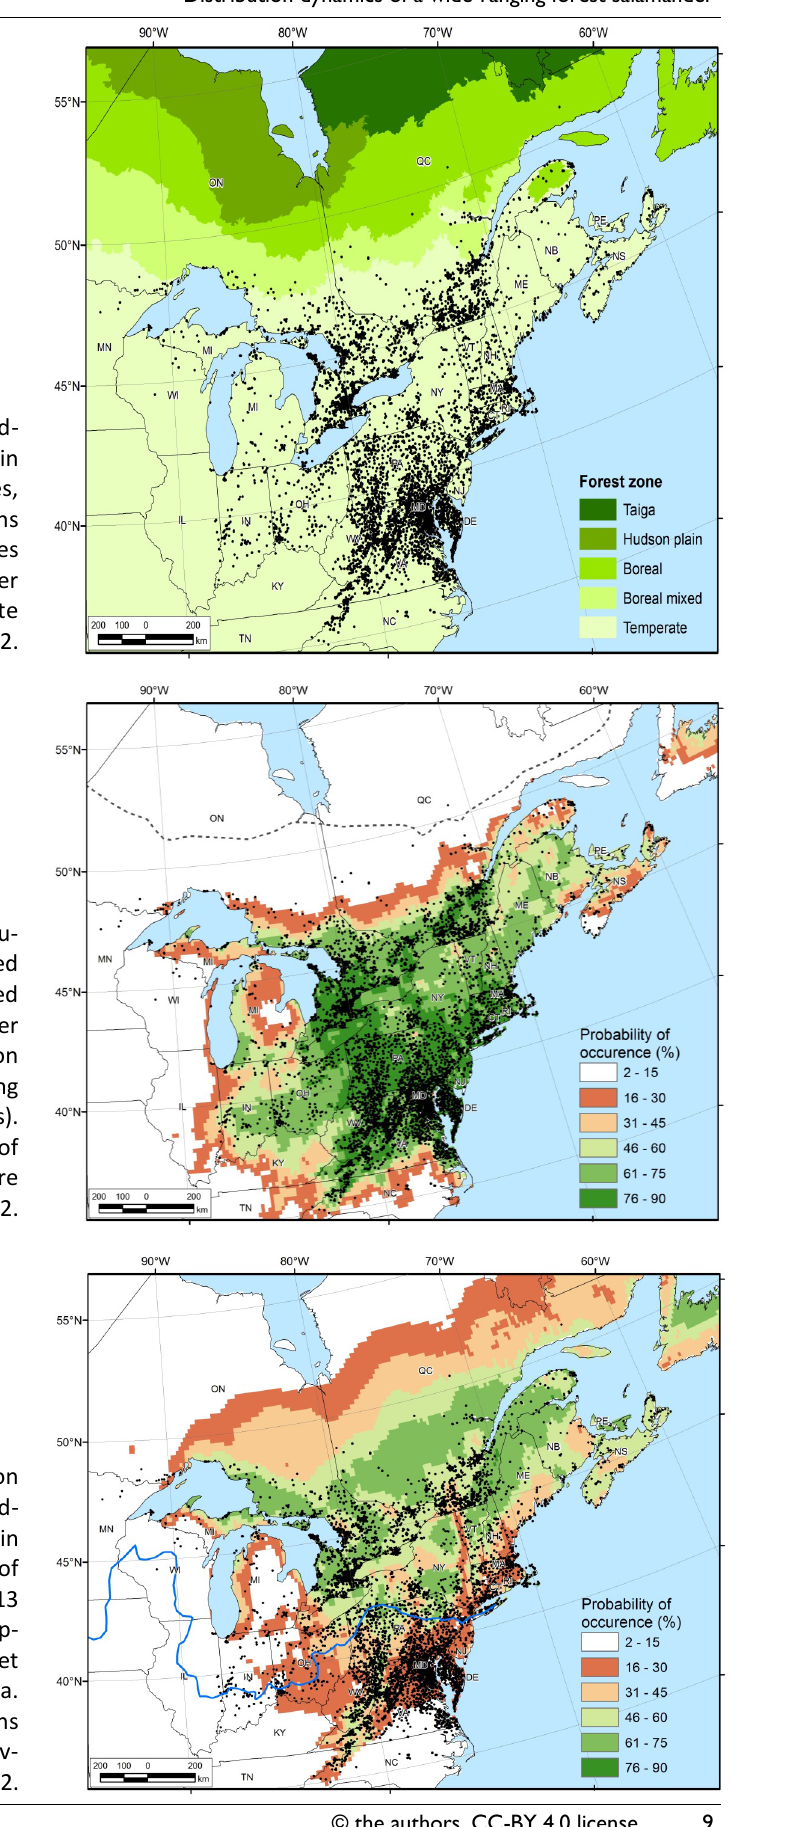
Figure 6. Consensus future modeled distribution (probability of occurrence) of the eastern red- backed salamander ( Plethodon cinereus ) in North America, based on a compilation of 400,090 observations dating from 1913 to 2013 in 8302 localities (dots). The solid blue line rep- resents the limit of the continental ice sheet during the last glacial maximum (ca. 15 000 years ago). Province/state abbreviations and number of sites/populations for each prov- ince or state are given in Table